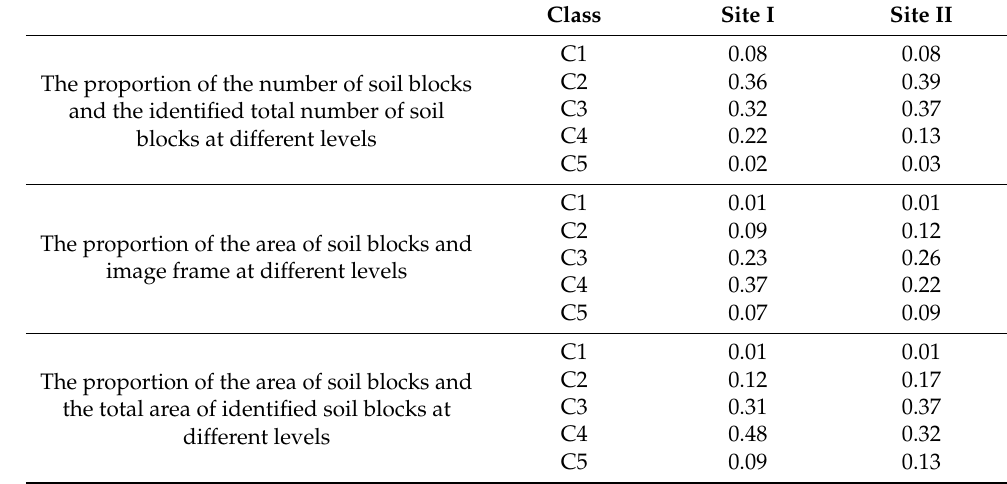
Table 4. Distribution statistics of soil blocks.